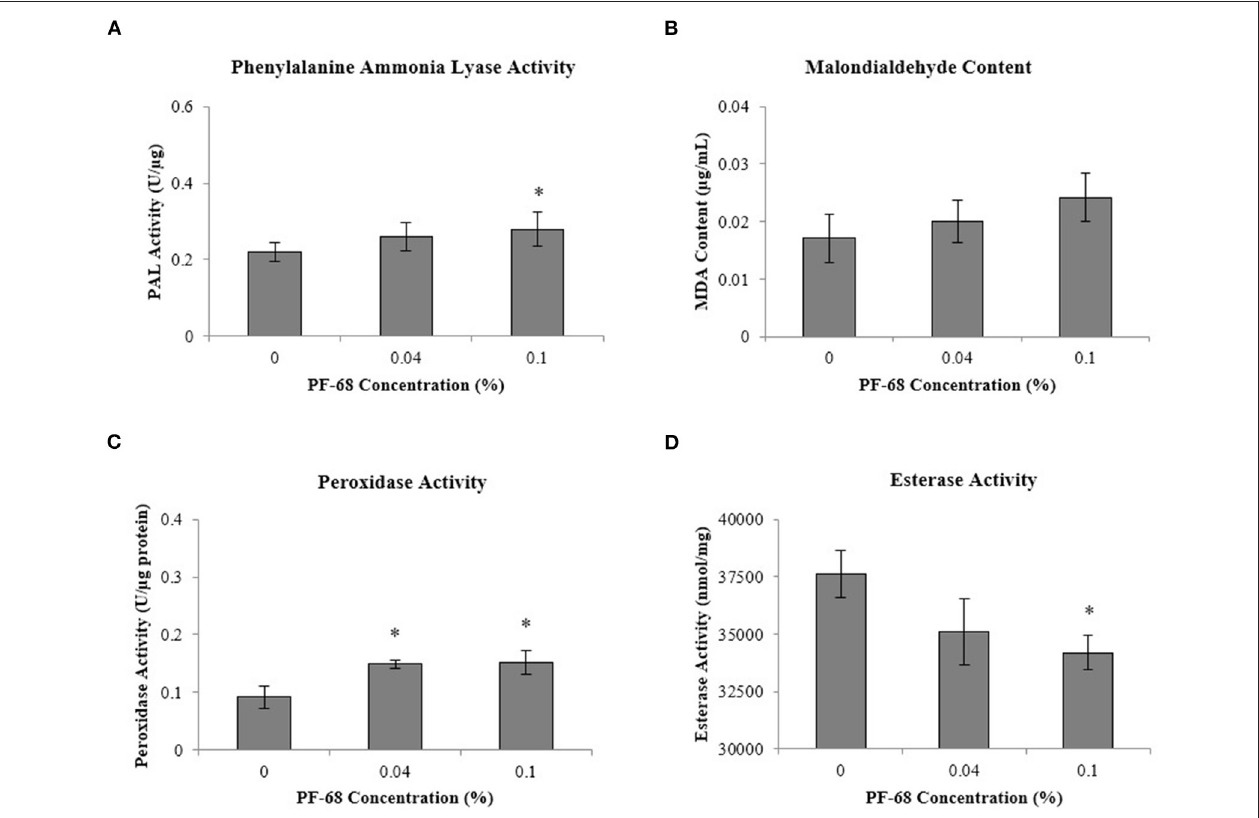
FIGURE 3 | Biochemical analysis performed on extracts of calli grown on Murashige and Skoog (MS) medium supplemented with different PF-68 concentrations without plant hormones (MSO). Control (MSO), optimum (MSO + 0.04% PF-68), and high (MSO + 0.10% PF-68). (A) Phenylalanine lyase (PAL) activity; (B) malondialdehyde (MDA) content; (C) peroxidase activity; (D) esterase activity. Data shows the mean of three biological replicates. Asterisks (*) indicate values were significantly different from those of the control callus at p < 0.05. Error bars represent SD of three biological replicates.